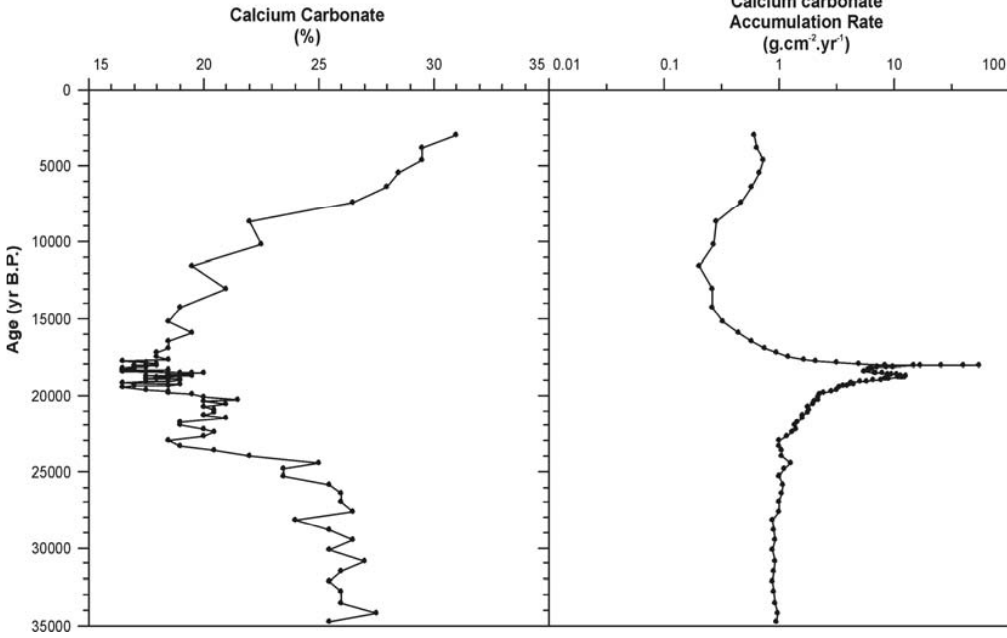
Fig. 4 – Variations in calcium carbonate content and carbonate Mass Accumulation Rate in core 7485. Isotope stage limits based on Martinson et al.